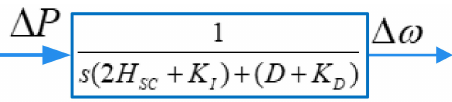
Figure 8. Simplified small-signal diagram of